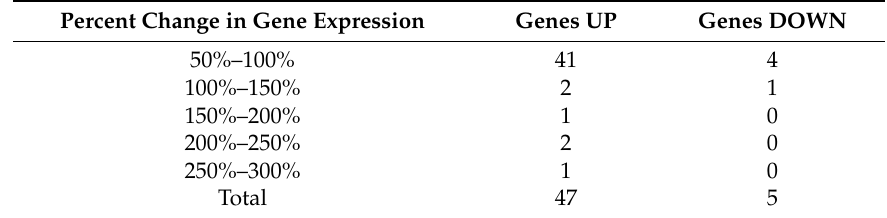
Table 7. Distribution of Genes Affected by GHK and Associated with DNA Repair.